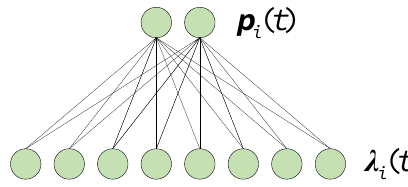
Figure 5. The position encoding